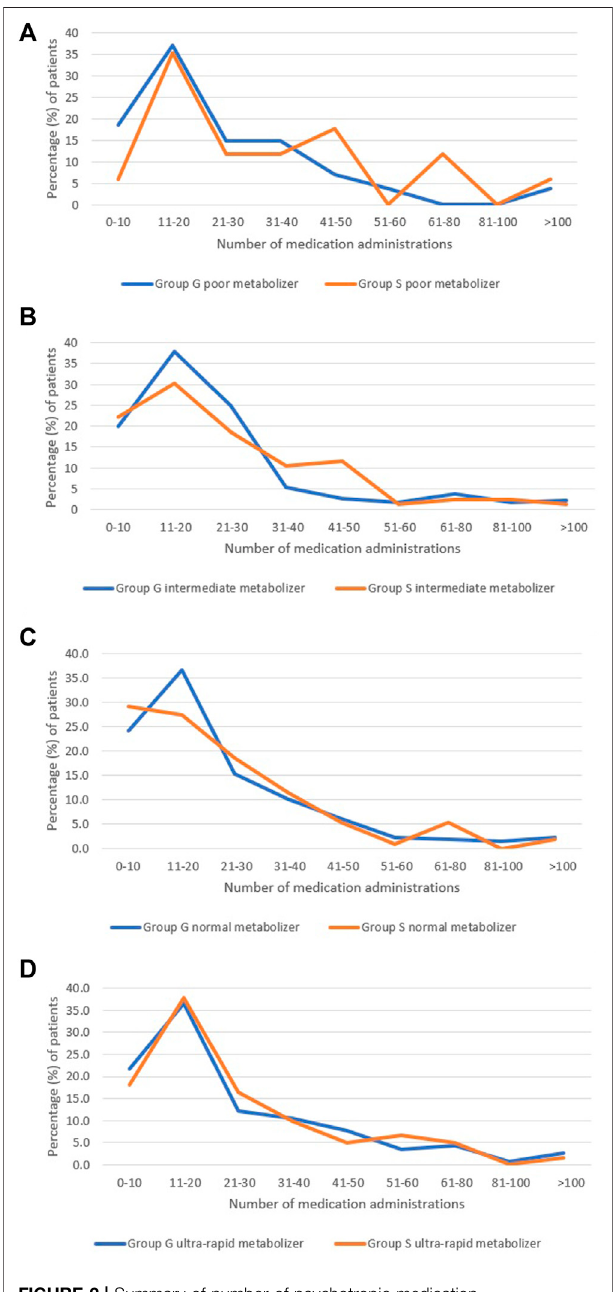
FIGURE 2 | Summary of number of psychotropic medication administrations among Groups G and S strati fi ed by CYP2D6 functional status. (A) : Number of psychotropic medication among Groups G and S in poor metabolizers. (B) : Number of psychotropic medication among Groups G and S in intermediate metabolizers. (C) : Number of psychotropic medication among Groups G and S in normal metabolizers. (D) : Number of psychotropic medication among Groups G and S in ultra-rapid